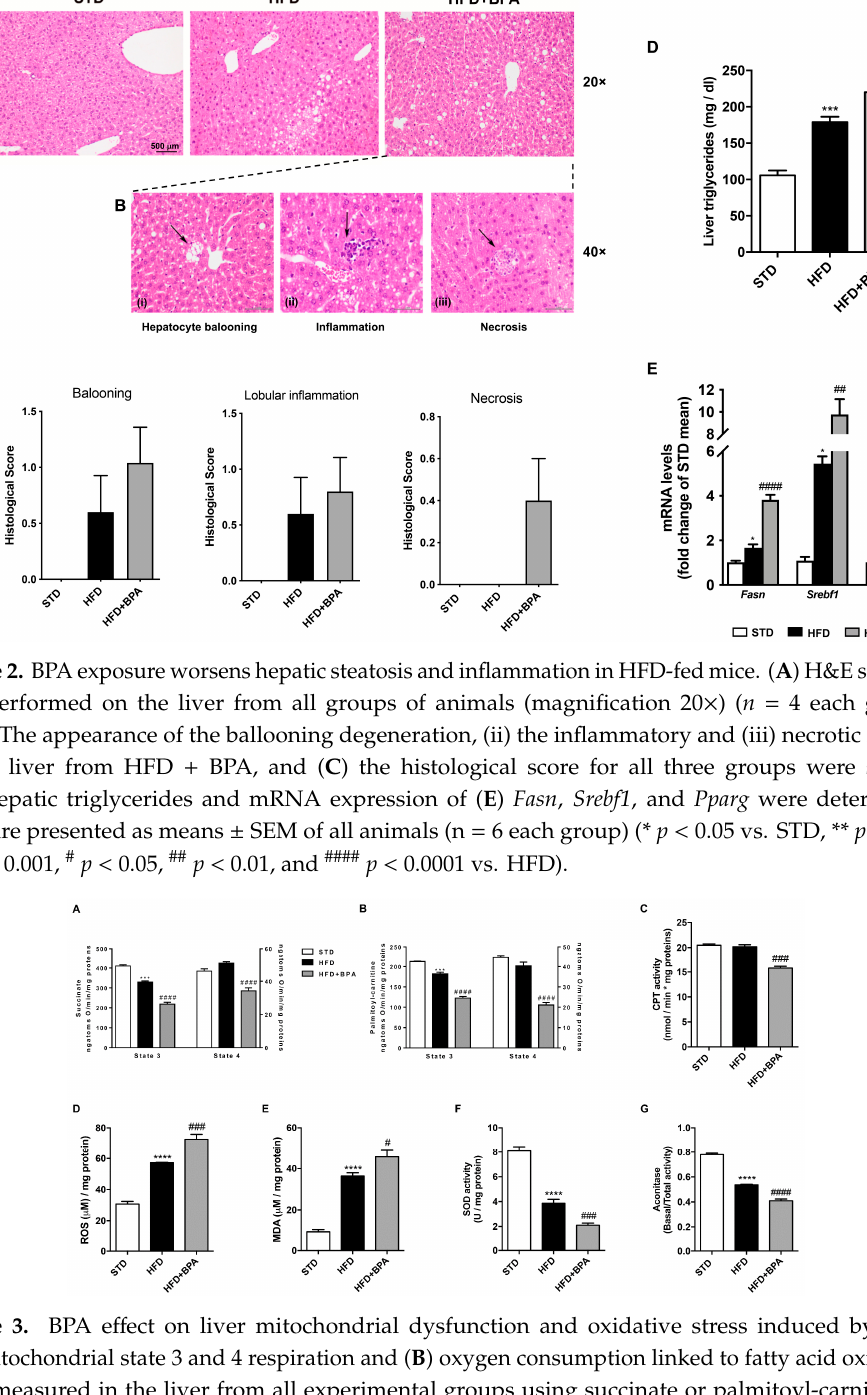
HFD. BPA significantly induced TLR4 protein expression and its downstream gene Myd88 (Figure 4A,B), as well as Nfkb1 mRNAs and the transcription of pro-inflammatory cytokines, including Tnfa , Il6 , and Ifng (Figure 4C,D). Notably, BPA toxic effect was linked to the inflammasome pathway activation, as shown by the marked induction of NLRP3 expression, and the following up-regulation of the adaptor ASC ( Pycard ), and caspase 1 ( Casp1 ) mRNAs, and the strictly related IL-1β ( Il1b) transcription (Figure 4E,F), already altered by HFD. Notably, BPA induced the hepatic monocyte and macrophage recruitment, as shown by the increase of MCP1 ( Ccl2 ) and macrophage recruitment factor Cd11c ( Itgax ) mRNAs (Figure 4G).